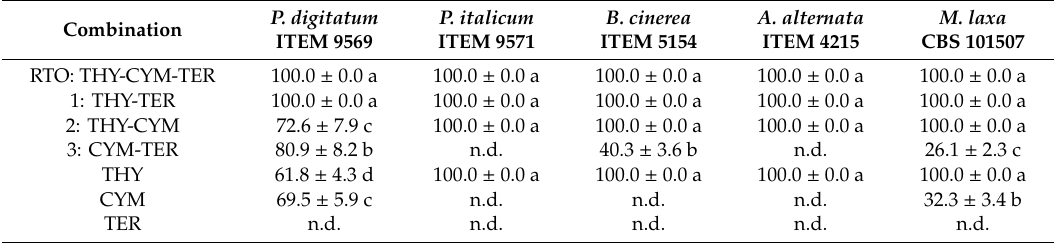
Table 3. Percentages of reduction (%) in fungal biomass of di ff erent fungal strains after exposure (72 h at 25 ◦ C) to di ff erent combinations of thymol (25.7 µ g / L), p-cymene (20.0 µ g / L), and γ -terpinene (11.4 µ g /